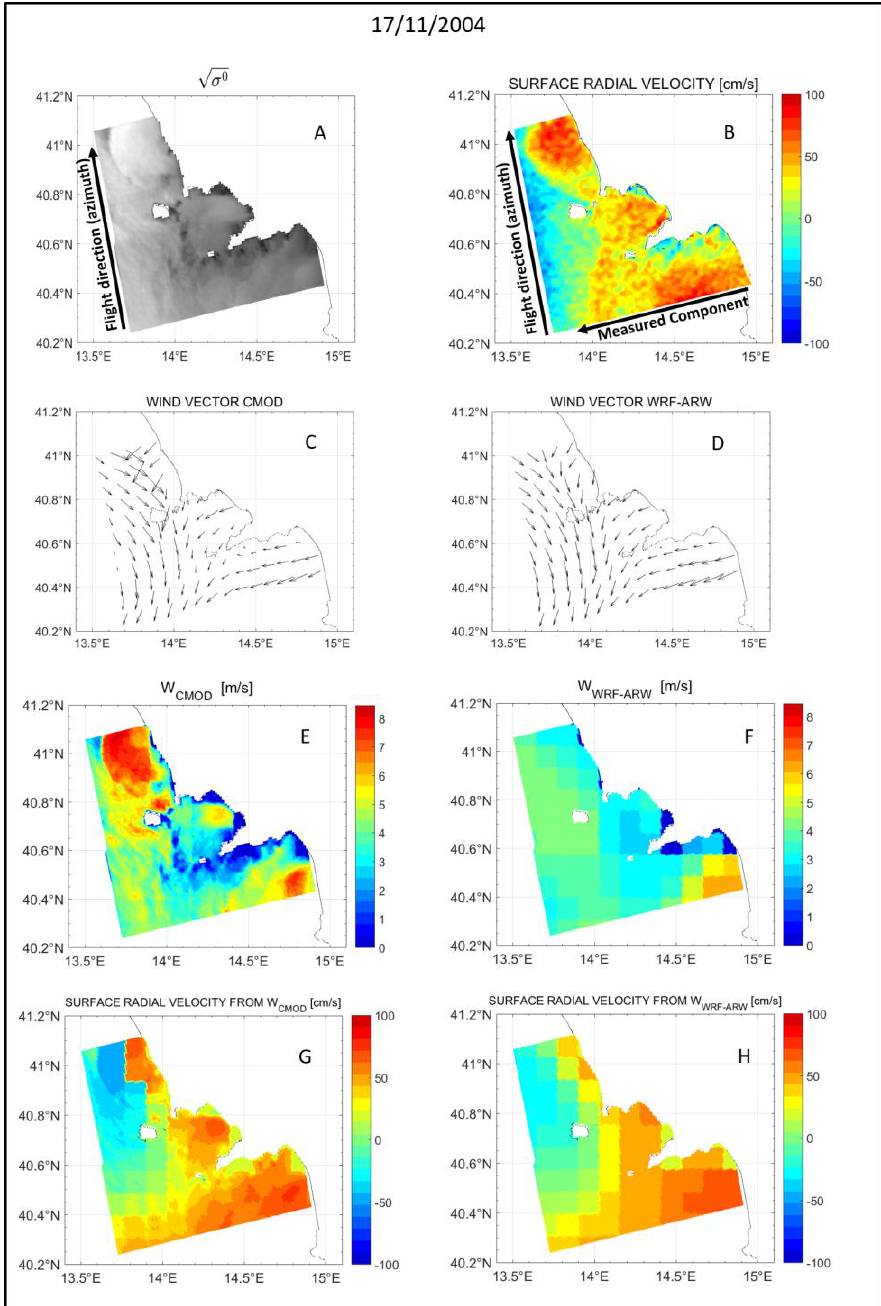
Figure 6. Results related to the acquisition of 17/11/2004.The image is divided as follow: ( A ) is the 𝜎 0 ; ( B ) is the estimated Doppler Anomaly maps of the marine area converted into the line-of-sight component of the sea surface velocity; ( C ) is the wind direction obtained from the CMOD model; ( D ) is the wind direction obtained from the WRF-ARW model; ( E ) is the wind speed relative to the CMOD model; ( F ) is the wind speed relative to the WRF-ARW model; ( G ) and ( H ) is the surface radial velocity due to the wind component, evaluated as descried in section 4, for the CMOD model and for the WRF-ARW model, respectively.